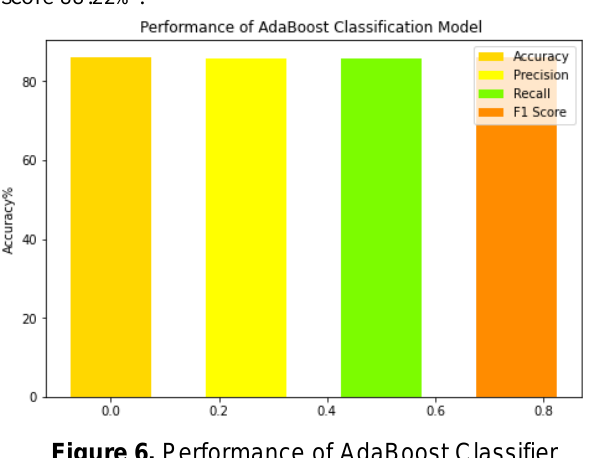
Figure 6. Performance of AdaBoost